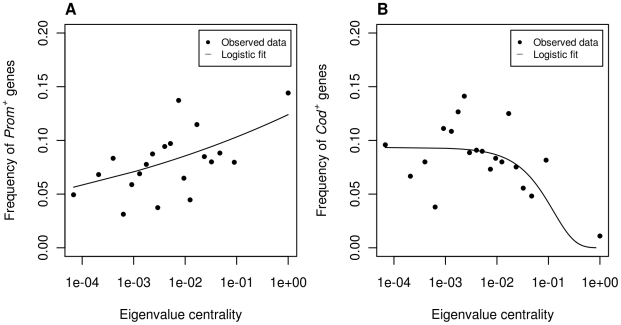
Association between the frequency of positively selected genes and centrality.
A. Logistic regression between the frequency of Prom+ genes and Eigenvalue centrality (EVC). B. Logistic regression between the frequency of Cod+ genes and EVC. In both panels, the X axis values correspond to the upper interval quantile of EVC in log coordinates.